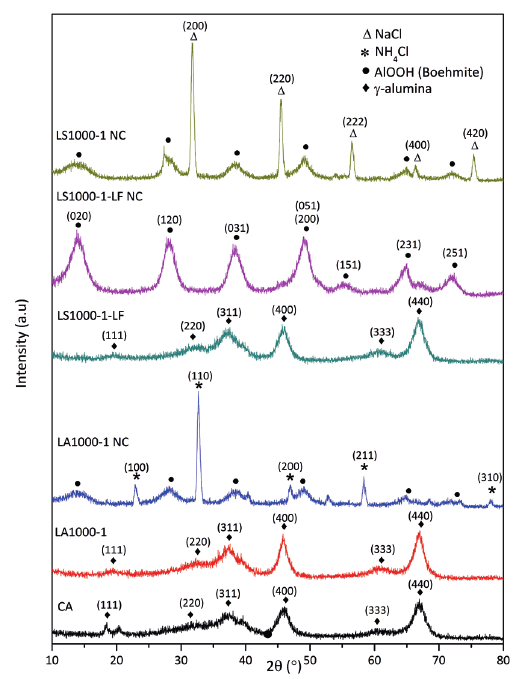
Figure 3: XRD profiles of the non-calcined (NC) and calcined solids at 800 o C.